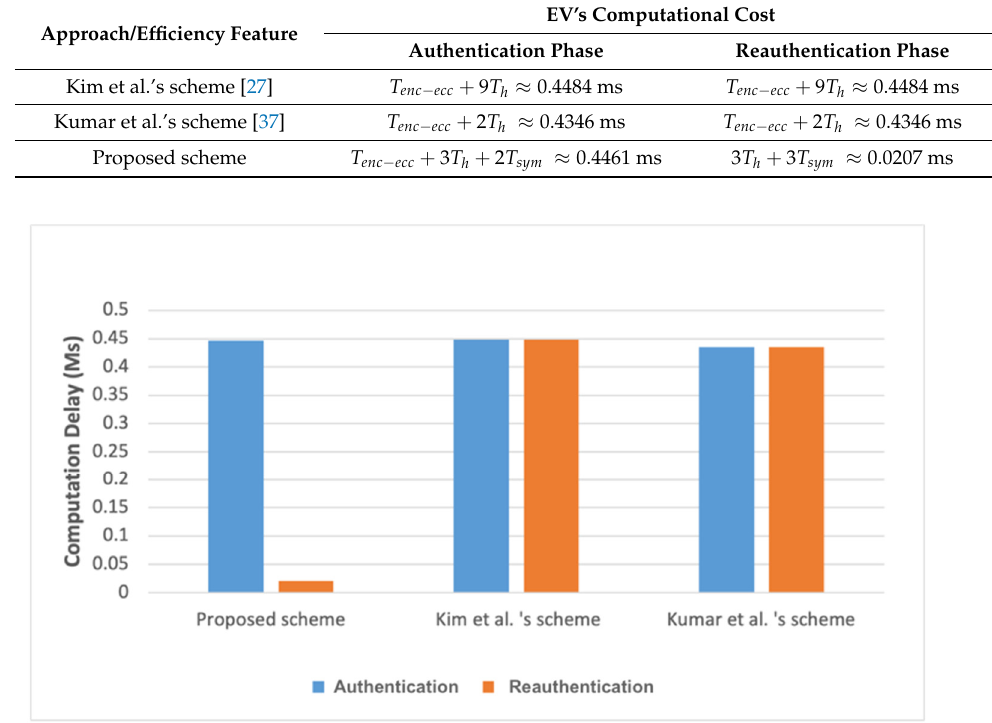
Figure 17. Comparison of several EV’s authentication protocols computational cost.